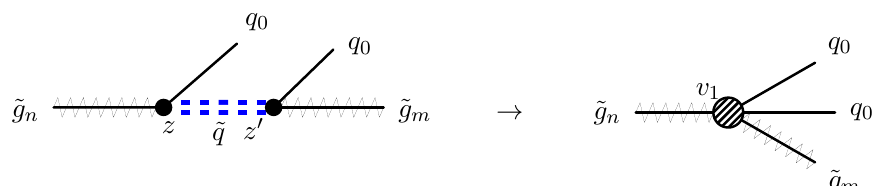
(cid:22) q 0 ~ g m e(cid:11)ective vertex (right) from the propagation of squark in 5D (left). L L